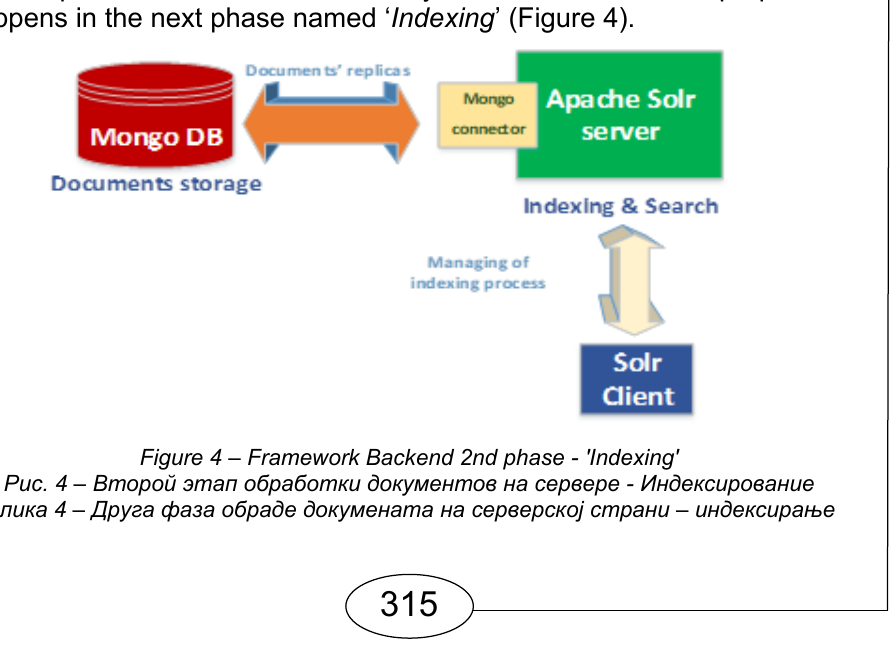
Figure 4 – Framework Backend 2nd phase -